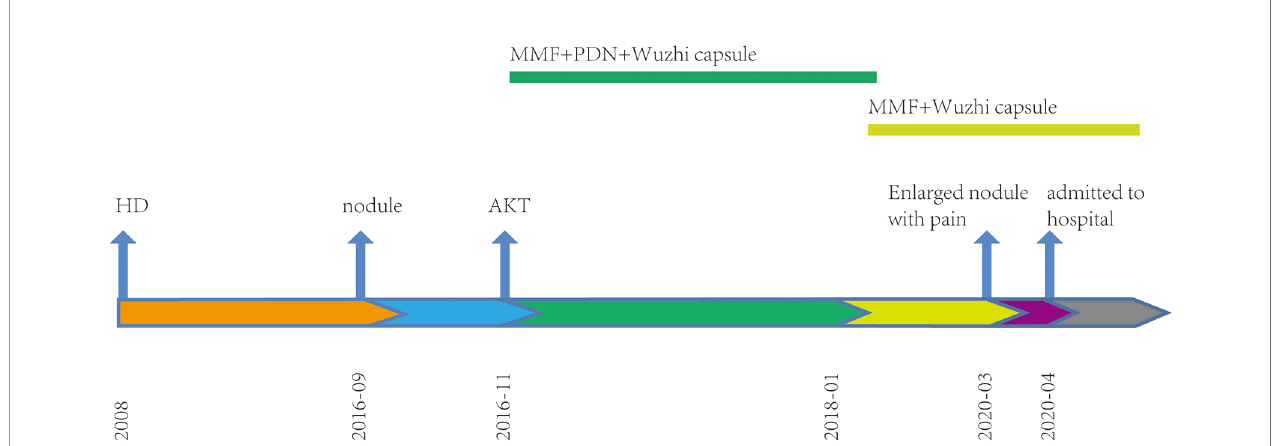
FIGURE 2 | Timeline. Treatment procedures since renal therapy. HD, hemodialysis; AKT, allograft kidney transplantation; MMF, mycophenolate mofetil; PDN,